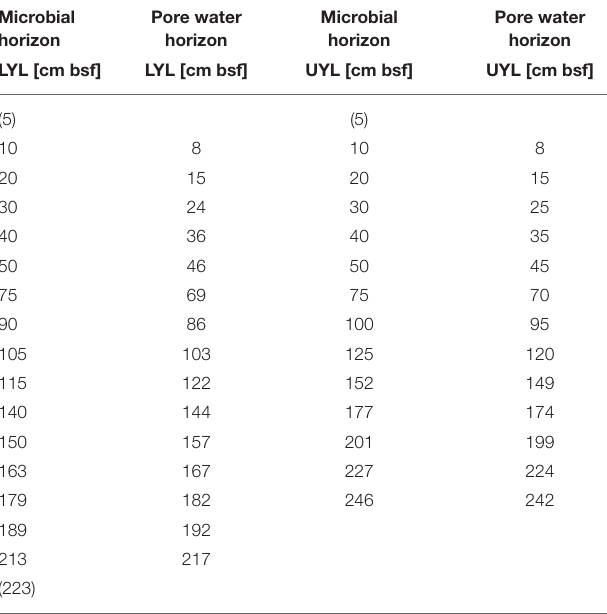
TABLE 1 | Adjusted sampling horizons for microbial community composition and pore water extraction. Microbial